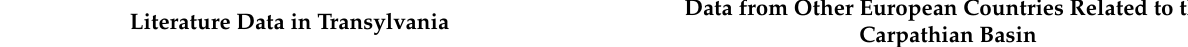
Table 2. Ethnomedicinal data of the selected pine species in Transylvania compared to the literature data from the region and other Central and South European countries related to the Carpathian